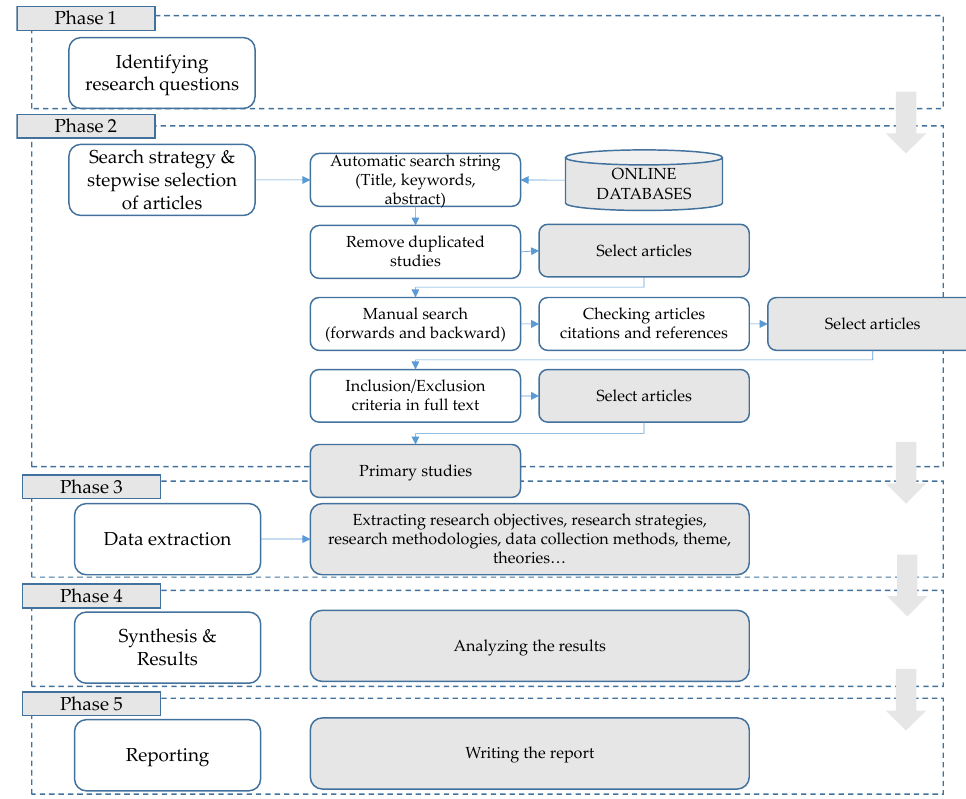
Figure 3. Research process map.